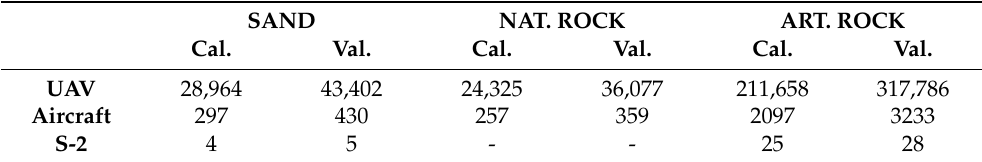
Table 4. Number of calibration and validation points used for each type of orthophoto (UAV, aircraft and S-2) for the three considered classes (sand, artificial and natural rocks). Portosole overlap area. SAND NAT. ROCK ART. ROCK Cal. Val. Cal. Val. Cal.